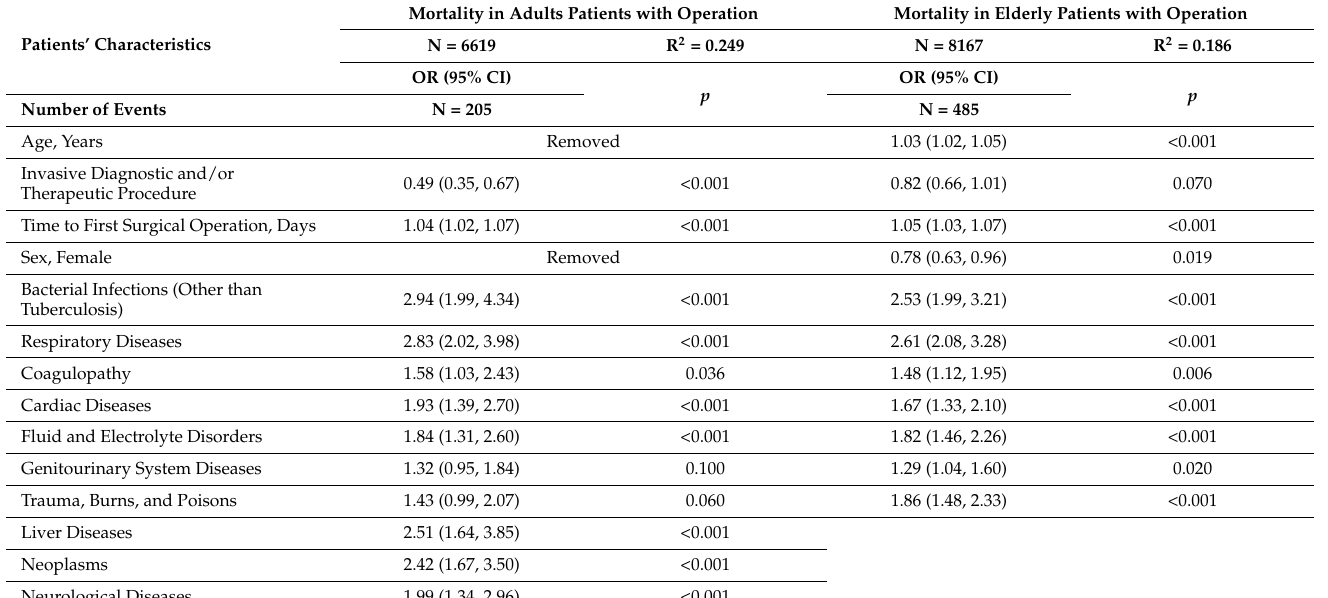
Table 5. Backward logistic regression analysis to evaluate the associations between mortality and different risk factors in patients emergently admitted with a primary diagnosis of malignant neoplasm of rectum or rectosigmoid junction and undergoing an operation (NIS 2004–2014). Mortality was the dependent